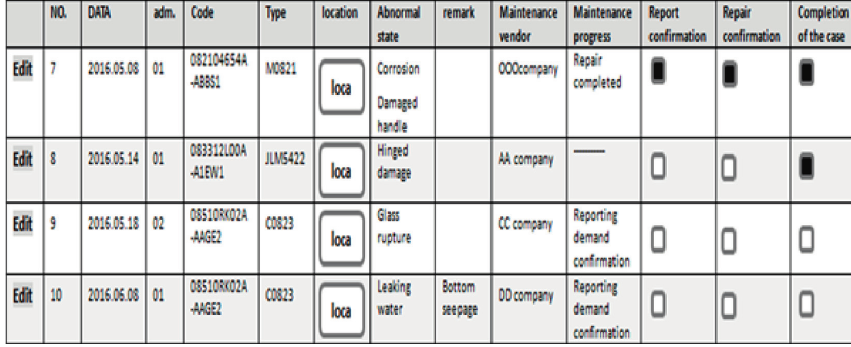
Figure 11: Illustration of request for repair menu